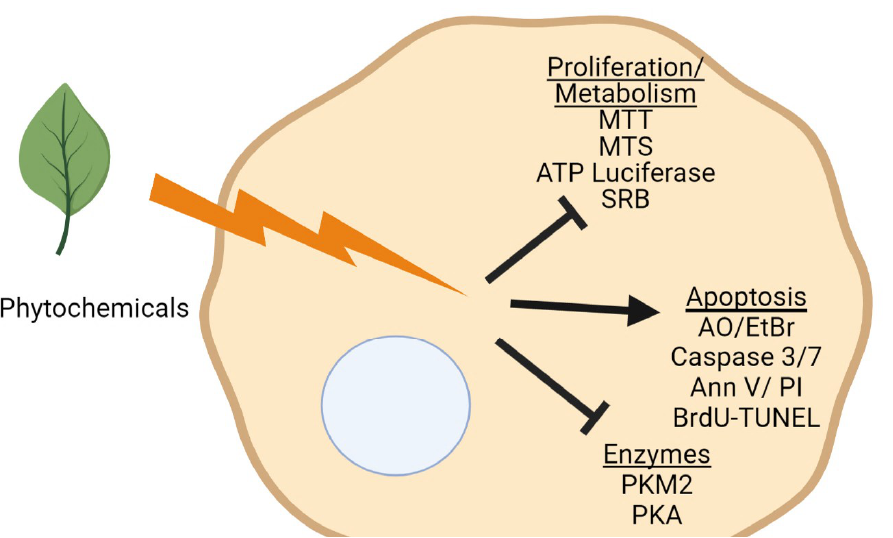
Figure 1. Anti-cancer bioassays to assess in vitro cellular effects of phytochemicals. The inher- ent antioxidant activities of phytochemicals may elicit anti-tumorigenic effects through either the inhibition of proliferation/cell metabolism, induction of cell apoptosis, or the inhibition of can- cer associated enzymes. Assays to assess each cellular function are listed below each under- lined function. MTT: 3(4, 5-dimethylthiazol-2-yl)-2, 5-diphenyltetrazolium bromide; MTS: 3-(4, 5-dimethylthiazol-2-yl)-5-(3-carboxymethoxyphenyl)-2-(4-sulfophenyl)-2H-tetrazolium; SRB: sul- forhodamine B; AO/EtBr: Acridine orange/ethidium bromide; Ann V/PI: Annexin V/Propidium Iodide; BrdU-TUNEL: bromodeoxyuridine-Terminal deoxynucleotidyl transferase-mediated d-UTP nick end labeling; PKM2: pyruvate kinase M2; PKA: protein kinase A. (Created with